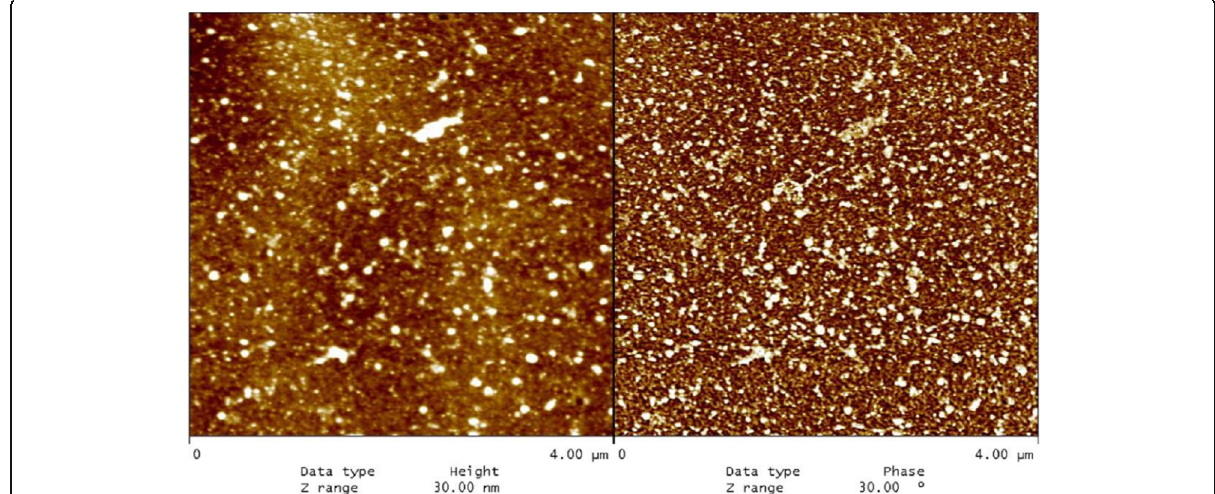
Fig. 1 AFM topography (left panel) and phase contrast image (right panel) for the functionalized graphene/PU hybrid coatings containing